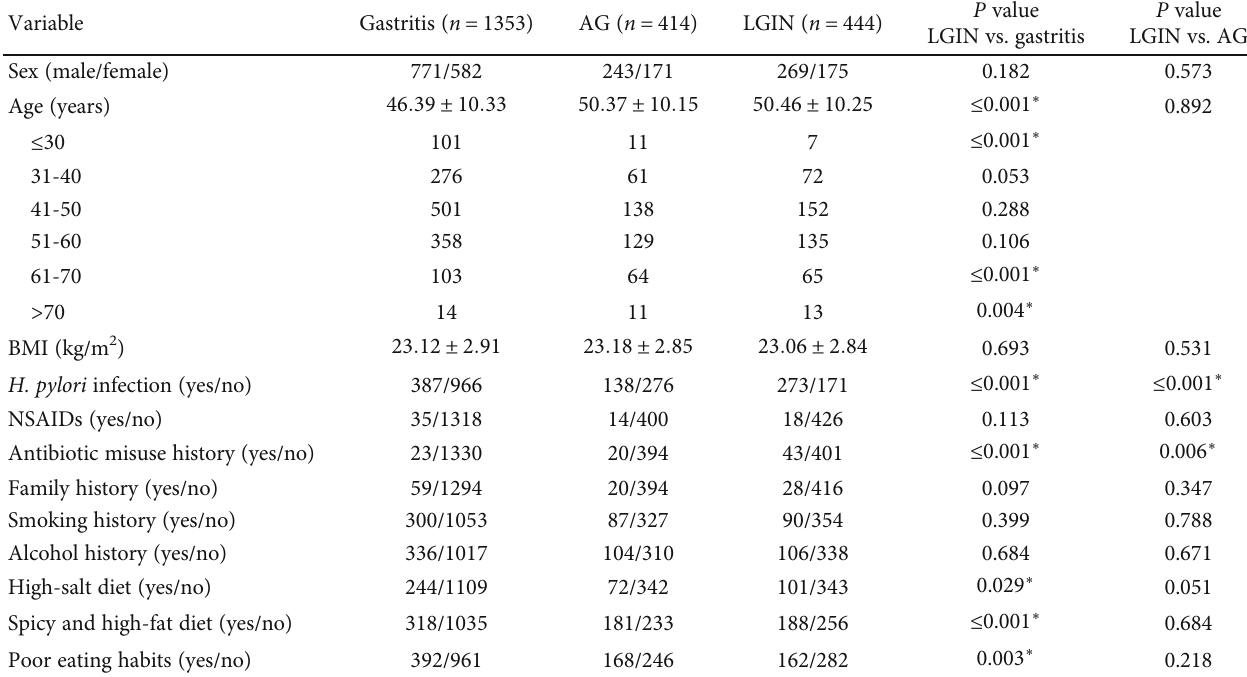
Table 2: Univariate analysis of common risk factors for LGIN among asymptomatic subjects.